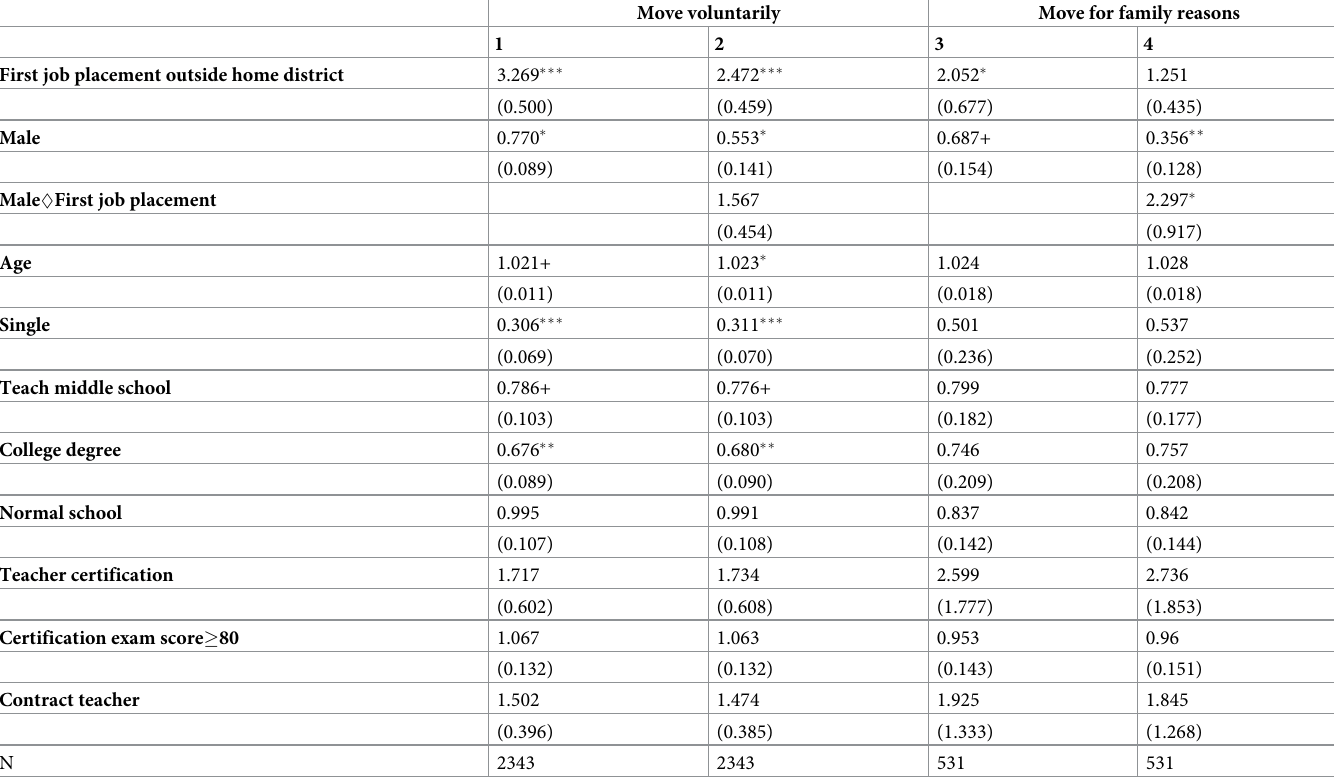
Table 5. Estimation results of the relationship between first job placement and reasons to